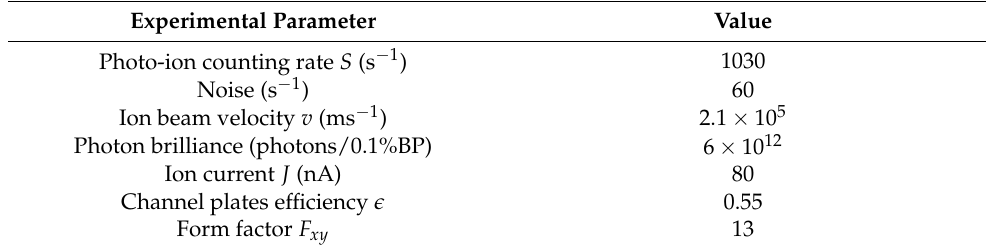
Table 1. Values of experimental parameters used to evaluate the absolute photoionization cross- section at 400 eV photon